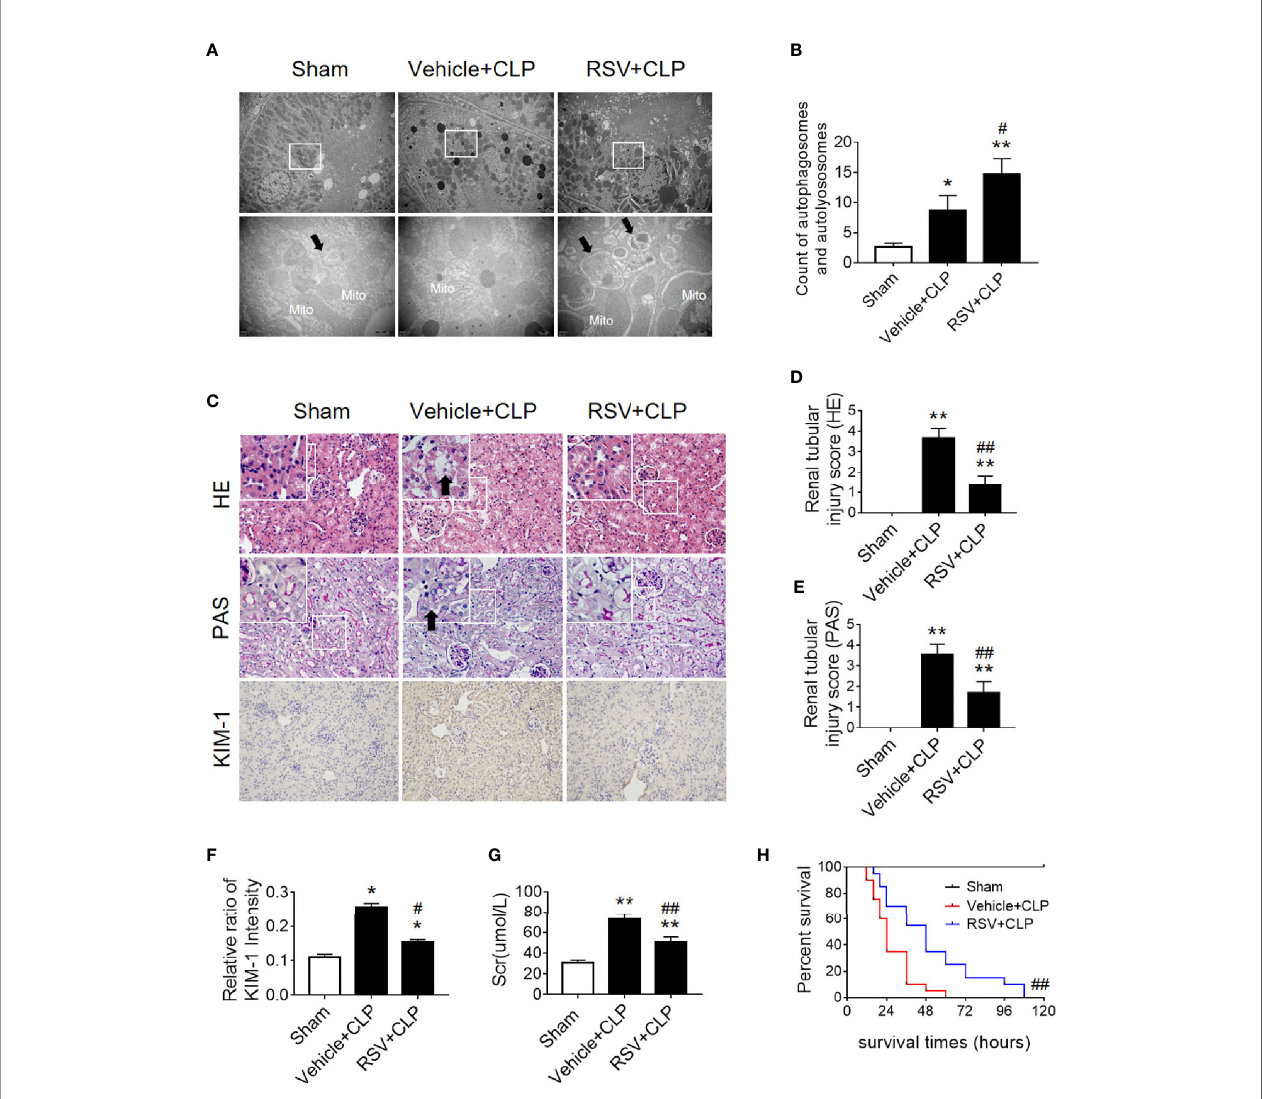
FIGURE 9 | Activation of the deacetylase Sirt1 by RSV promotes autophagy and reduces SAKI. (A) Effect of Sirt1 activation by RSV on autophagy in the renal cortex of CLP-induced septic mice. Black thick arrows: autophagosomes or autolysosomes; Mito, mitochondria. Upper panel: magni fi ed ×7,000; lower panel: magni fi ed ×40,000. (B) Semi-quantitative analysis of autophagy. The number of autophagosomes and autolysosomes in renal epithelial cells was calculated in 20 randomly selected fi elds. (C) Effects of Sirt1 activation by RSV on kidney pathology, as evidenced by HE staining, PAS staining, and KIM-1 immunohistochemistry. Upper Panel: Hematoxylin-Eosin (HE) staining (200×; inset: 400×); Middle panel: periodic acid-Schiff (PAS) staining (200×; inset: 400×). Black thick arrows: Nucleus of RTECs shed to lumen; Lower panel: KIM-1 immunohistochemistry (200×). (D, E) The tubular damage score was evaluated based on pathological observations from HE and PAS staining. These scores are based on the data obtained from the observation of 5 specimens in each group with 10 randomly selected fi elds of view from a 200× microscope for each specimen. (F) Relative ratio of kidney injury molecule-1 (KIM-1). The data were obtained from at least three independent experiments. (G) Effect of Sirt1 activation by RSV on the level of sCr. (H) Effects of Sirt1 activation by RSV on the survival times in CLP-induced septic mice. The survival rates were estimated by the Kaplan-Meier method and compared by the log-rank test. n = 20. * p < 0.05, ** p < 0.01 vs. sham group; # p < 0.05, ## p < 0.01 vs. the vehicle + CLP group. CLP, cecal ligation and puncture; RTEC, renal tubule epithelial